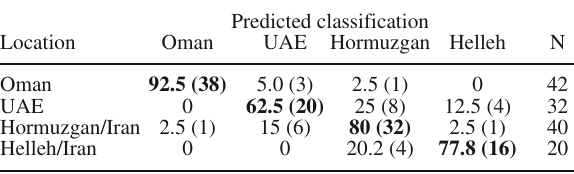
The percentages in rows represent the classification into the popu- lations given in columns (correct classifications are highlighted in bold); corresponding numbers of individuals are given in brackets. Overall classification success is 88.6% (Wilks’ λ =0.039 for func- tion 1 and 0.328 for function 2). N , number of individuals; UAE, United Arab